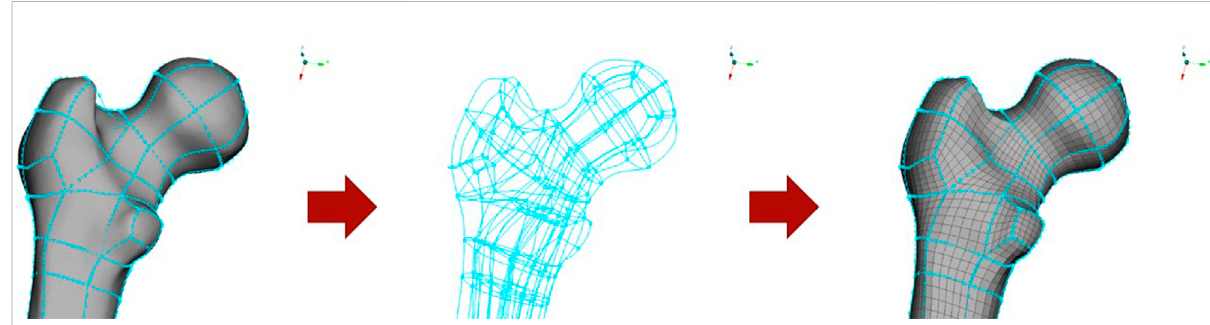
FIGURE 1 Hexahedral meshing of anatomical components, using hexaboxes approach where the geometry is subdivided into larger hexahedral shapes for control of element quality and fl ow.